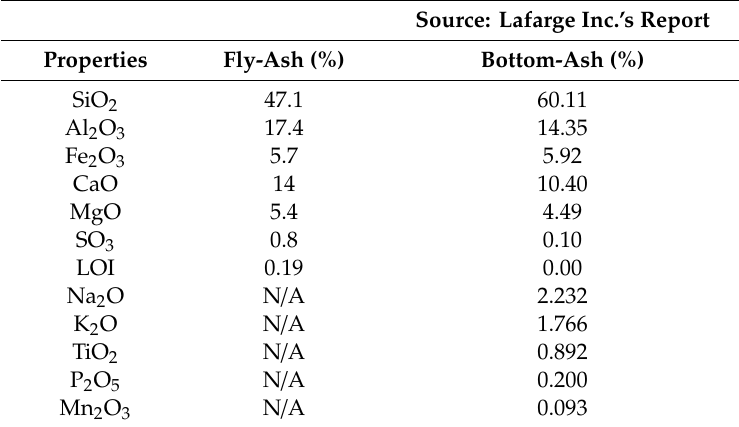
Table 1. Chemical Compositions of fly-ash and